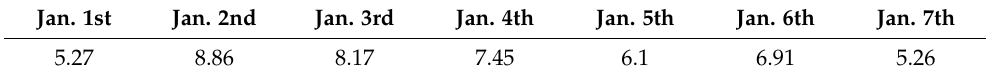
Table 6. H 2 (m) during 14:00–18:00.